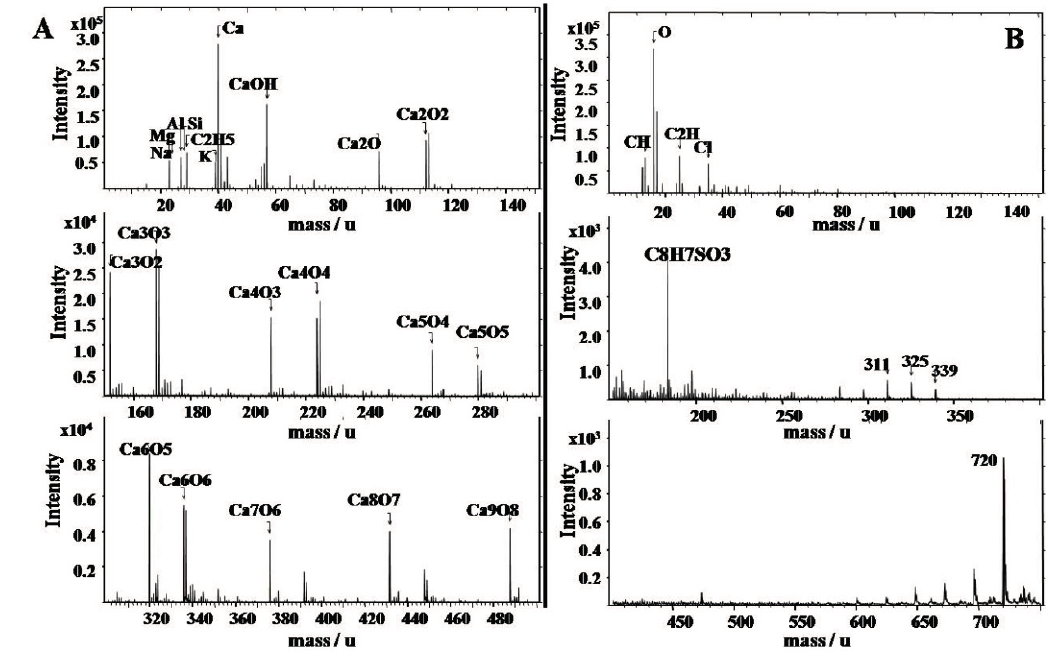
Figure 5. Qualitative chemical composition analysis by Time of Flight Secondary Ion Mass Spectrometry. Column ( A ), the positively charged ions. Column ( B ), the negative charged